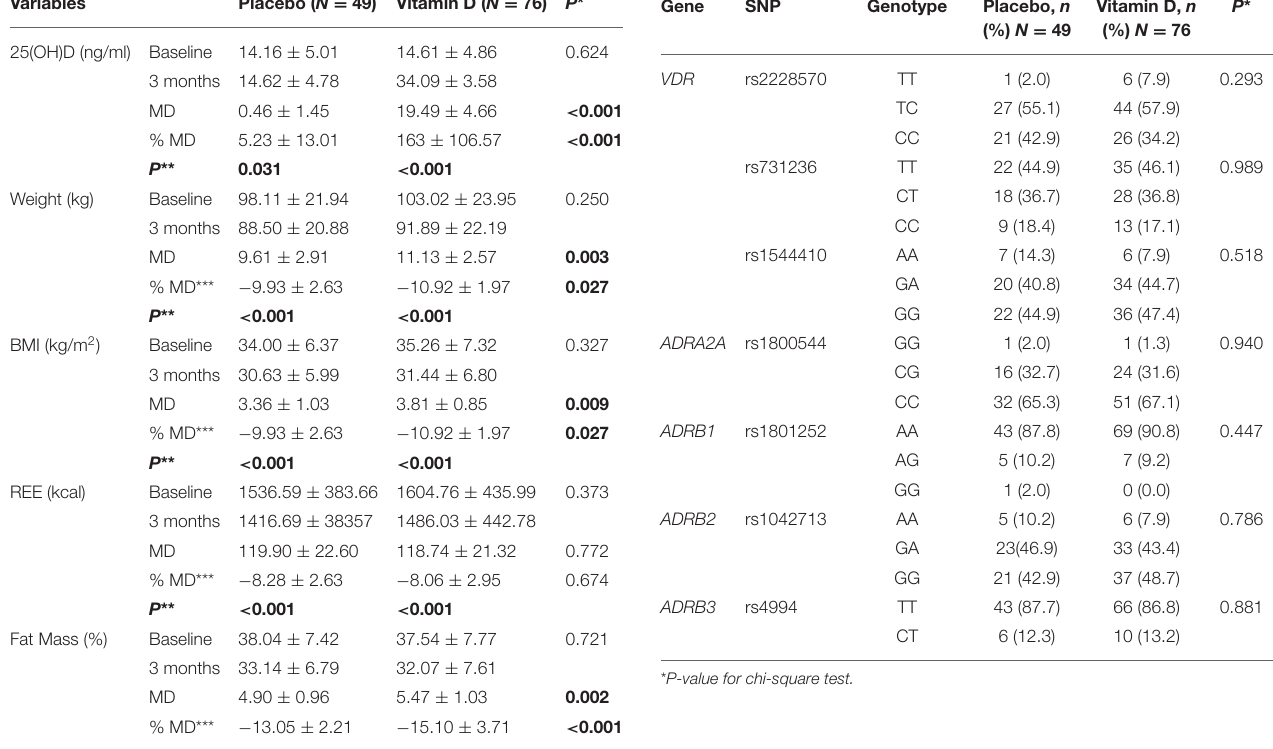
TABLE 3 | Genotype distribution frequencies of VDR , ADRA2A , ADRB1 , ADRB2, ADRB3 gene polymorphisms in the study groups. Gene